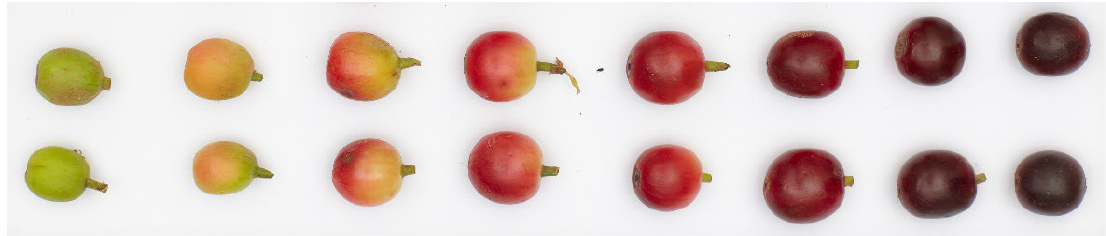
Figure 6. The maturation of arabica coffee cherries from green (unripe) to red (ripe) to overripe (dark red).